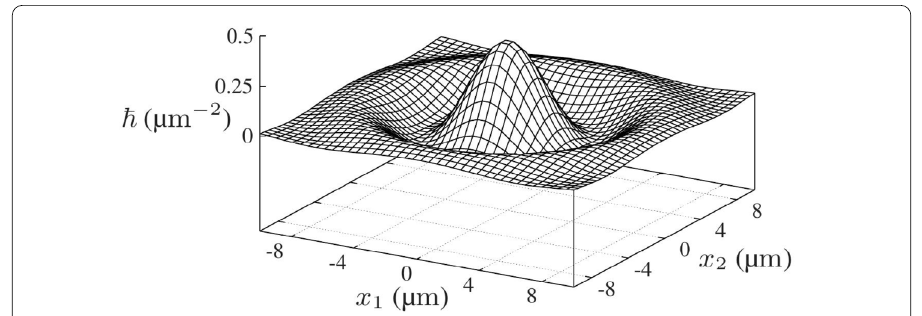
μ m –1 and (cid:7) 1 = 1 μ m –1 2